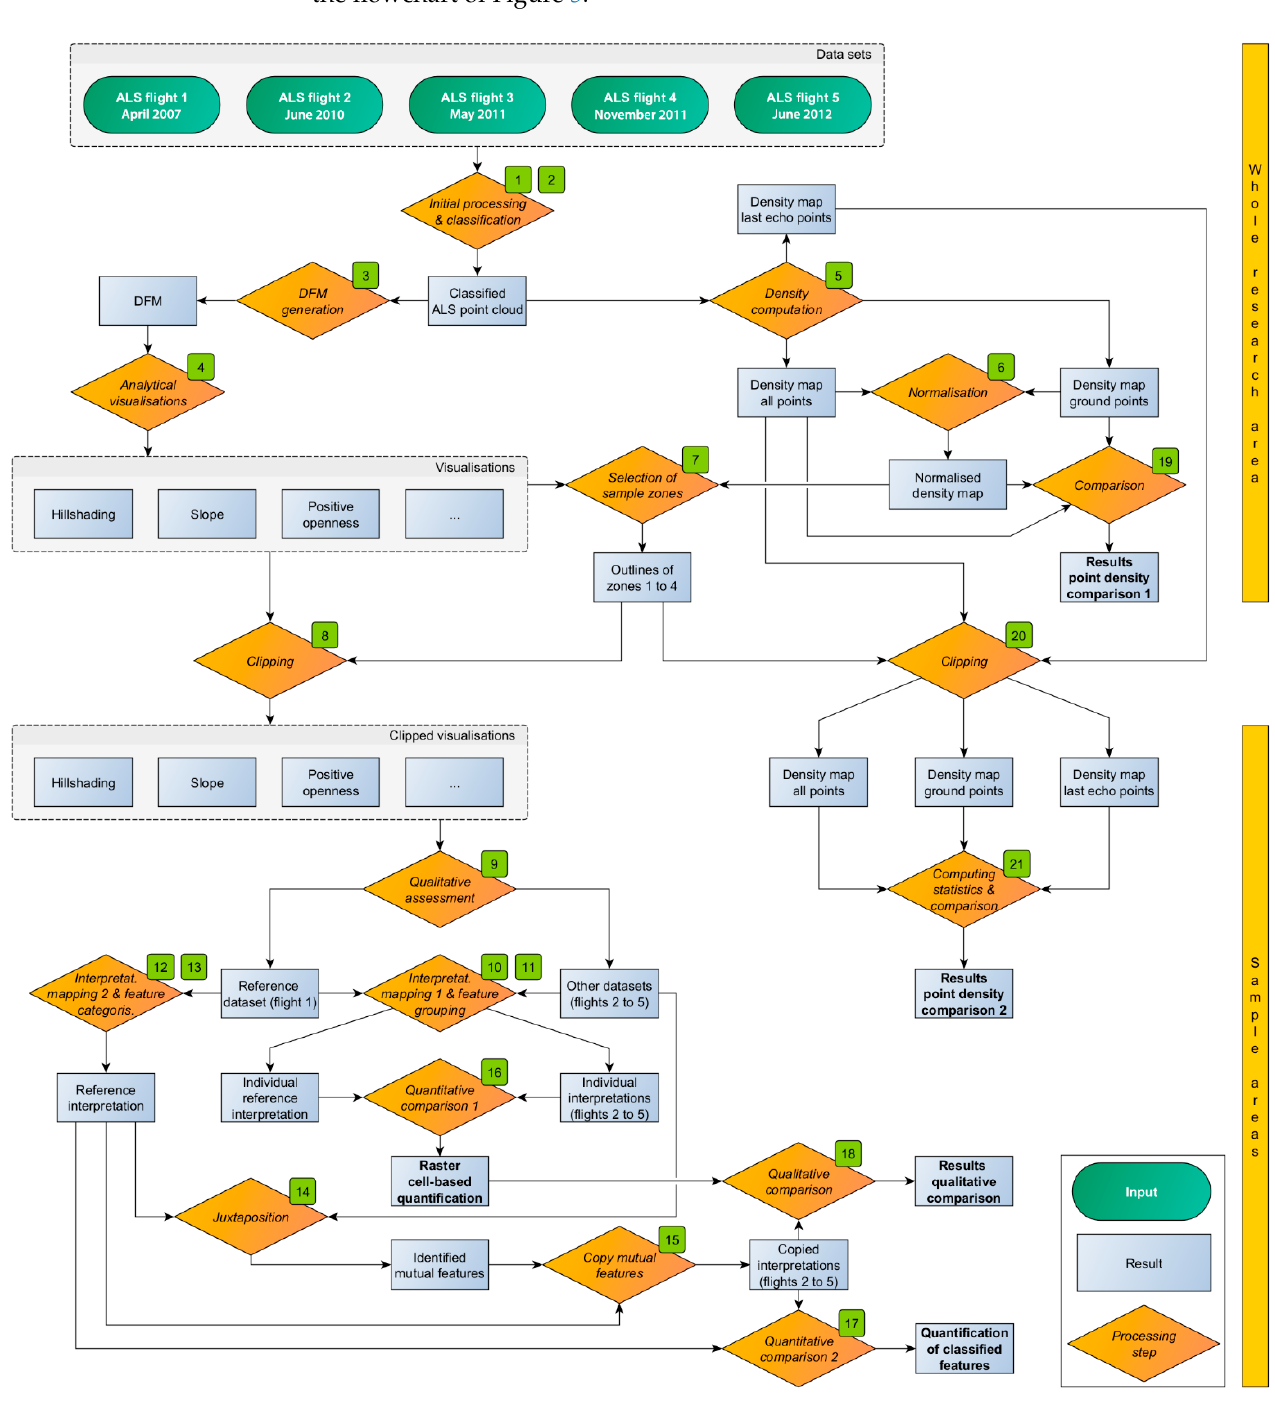
Figure 5. Diagram of the complete workflow described in the text.